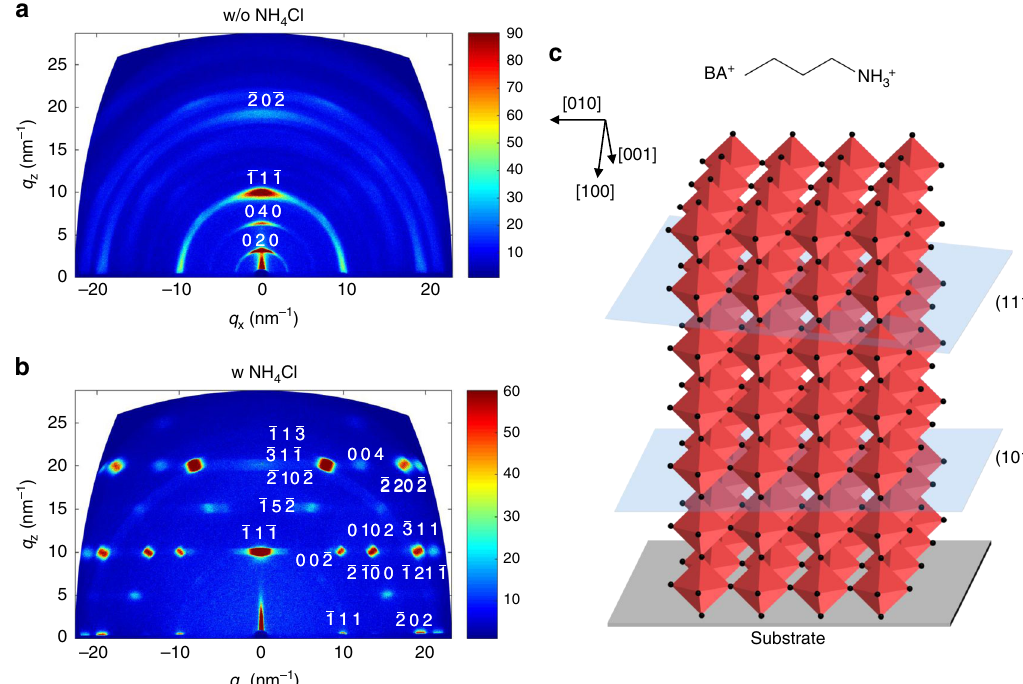
Fig. 1 Effect of NH 4 Cl additive on crystallization and orientation. a , b GIWAXS patterns of BA-based RP fi lms (< n > = 4) spun from precursor solution without additive ( a ) or with NH 4 Cl additive ( molar ratio of NH 4 Cl/PbI 2 = 0.5) ( b ). c Illustration of BA molecular structure and RP perovskites with out-of- plane